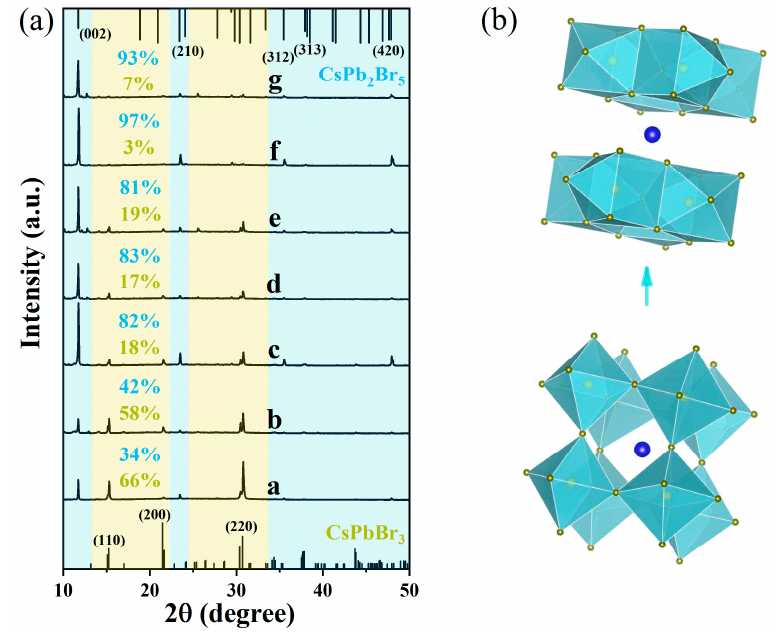
Figure 2. ( a ) X-ray diffraction (XRD) patterns of sample a-g; ( b ) Schematic representation of mixed-solvent polarity assisted the transition of orthorhombic CsPbBr 3 to tetragonal CsPb 2 Br 5 .